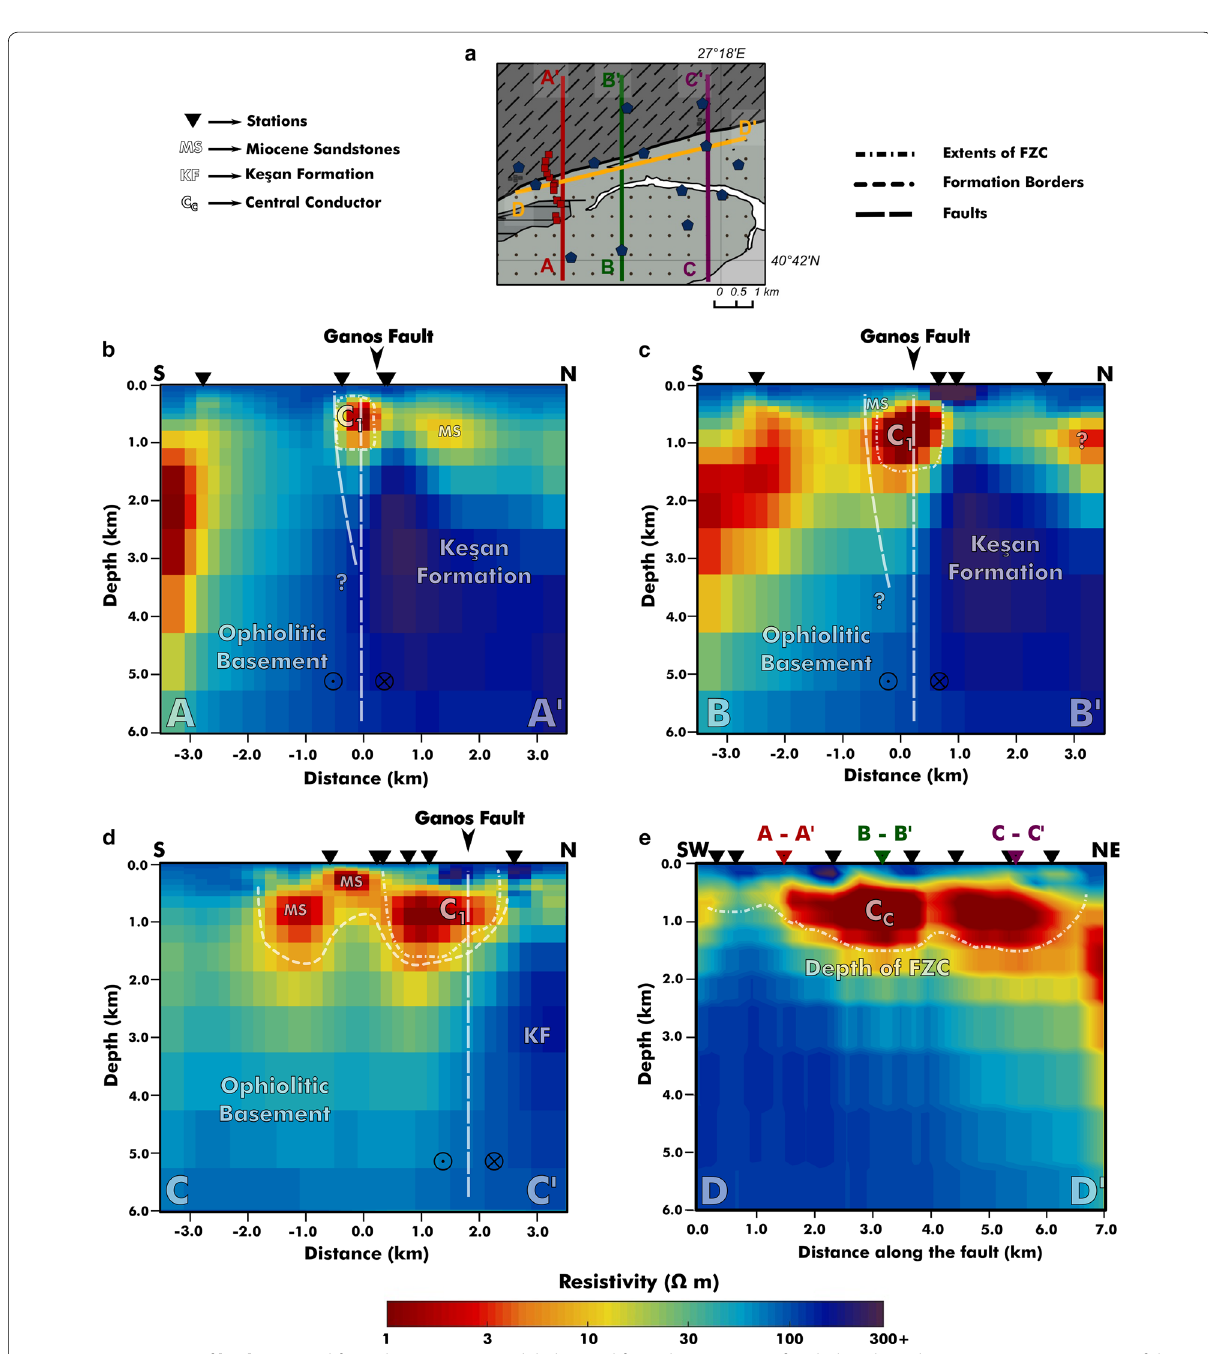
Fig. 6 Cross sections of b–d extracted from the resistivity model obtained from the inversion of wide-band MT data. a Map representation of the cross-sectional locations. b–d North–south-aligned cross sections showing the spatial differentiation of the geological structures along the Ganos Fault, especially that of the damage zone. In all cross sections, conductive C 1 represents the fault zone conductor (FZC) of the main fault. e Trans- section parallel to the Ganos Fault that outlines the depth variation of the FZC. The central conductor, C c , represents a relatively higher conductive region of the fault zone. The descriptions of the different dashed lines , symbols, and acronyms are given in the legend. The resistivity color scale is